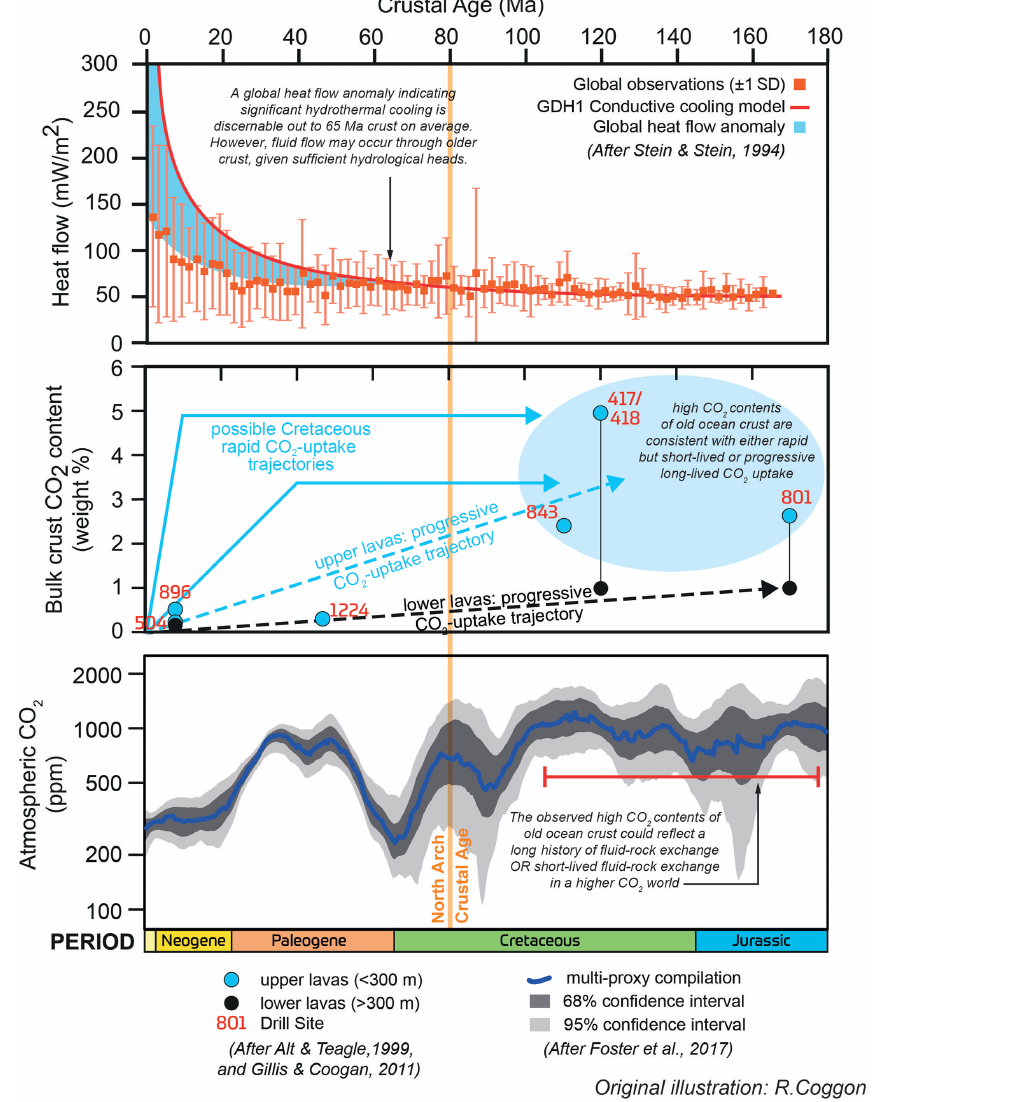
Figure 4. Drilling into the ∼ 80Ma oceanic crust on the North Arch will allow us to determine what controls the duration and rate of CO 2 uptake by the oceanic crust and to quantify the role of hydrothermal aging in the long-term global carbon